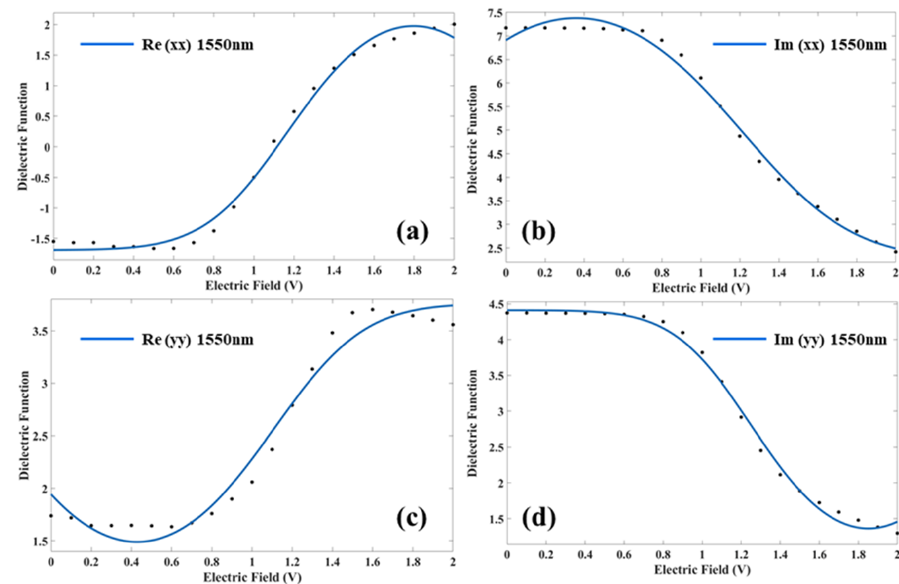
Figure 6. At 1550 nm, data points and fitted curves of the real portion ( a ) and imaginary portion ( b ) of the dielectric function in the x orientation under tunable external electric field, and data points and fitted curves of the real portion ( c ) and imaginary portion ( d ) of the dielectric function in the x orientation under tunable external electric field. The fit coefficients and mean squared deviations (R-square) are shown in Table 1. Fit coefficients of the real and imaginary parts of the dielectric functions in the x and y orientations.